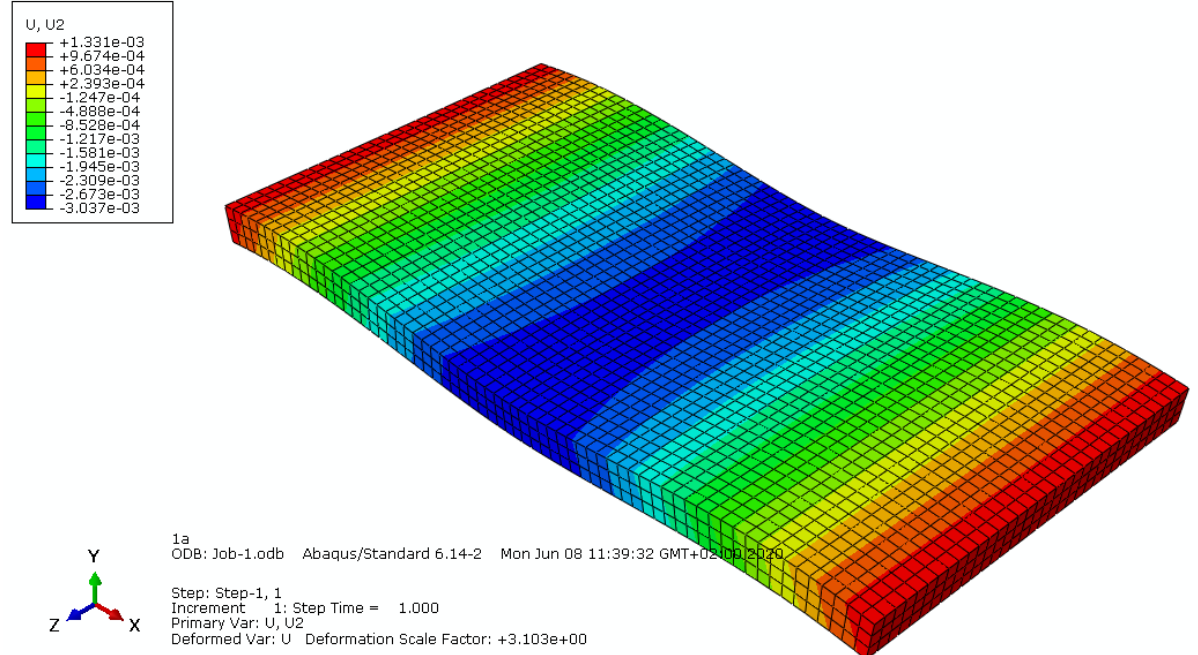
Figure 9: Example deflections for the force F